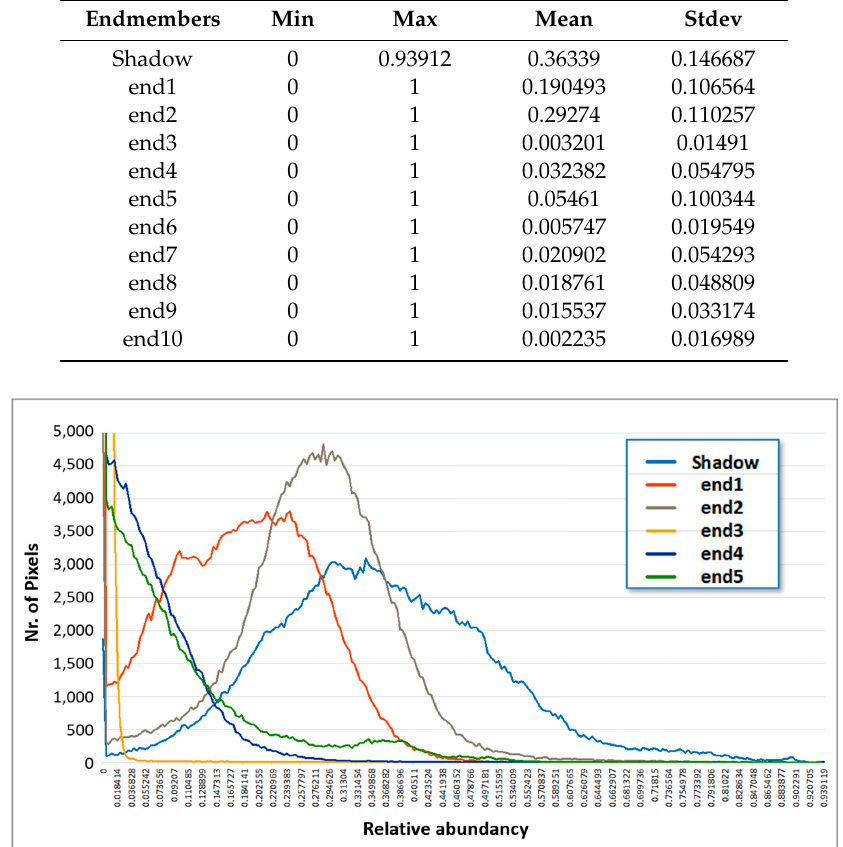
Figure 5 . Histogram distribution of the first EM abundances including shadow. Figure 5. Histogram distribution of the first EM abundances including